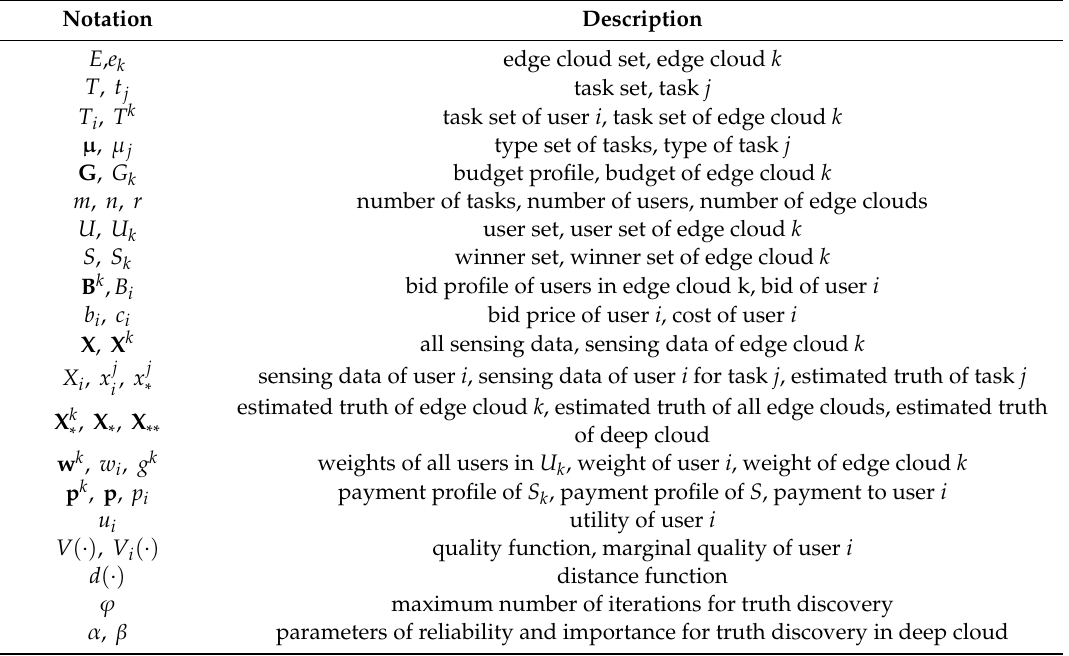
Table 1. Frequently used